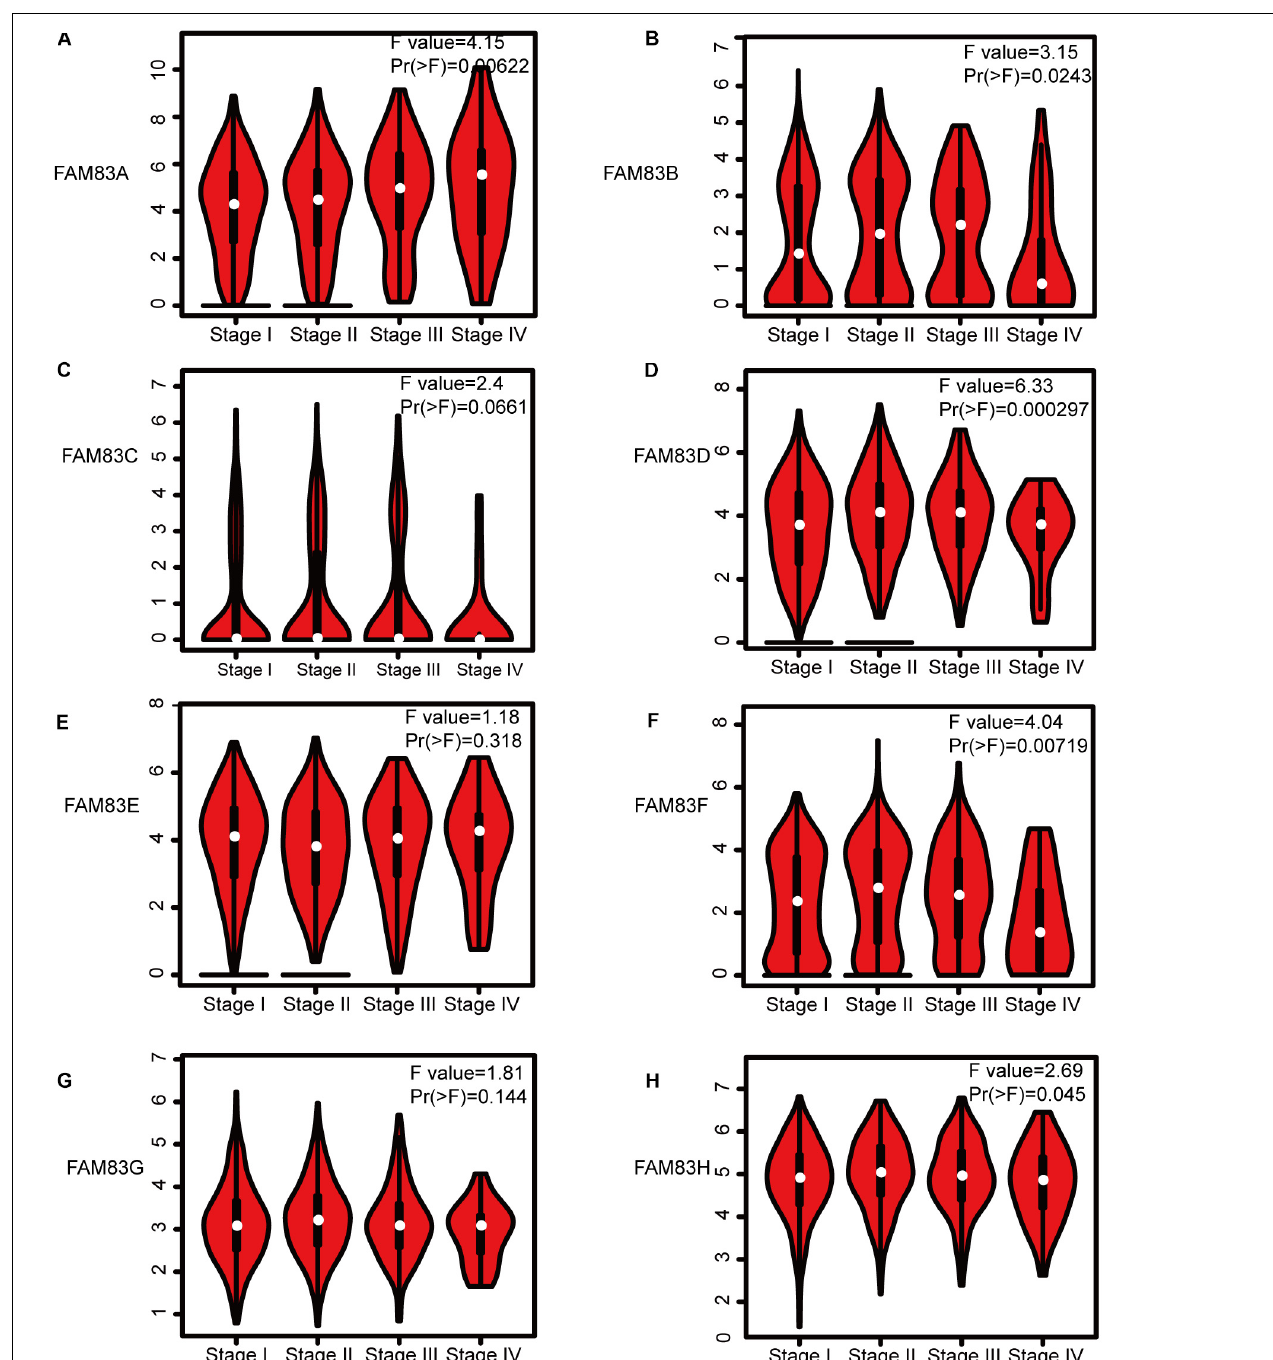
FIGURE 4 | Correlation between FAM83 family expression and tumor stage in NSCLC patients (GEPIA). The mRNA expressions of FAM83A/B/D/F/H were significantly related to patients’ individual cancer stages (A,B,D,F,H) , while mRNA expressions of FAM83C/E/G were not associated with patients’ individual cancer stages (C,E,G)